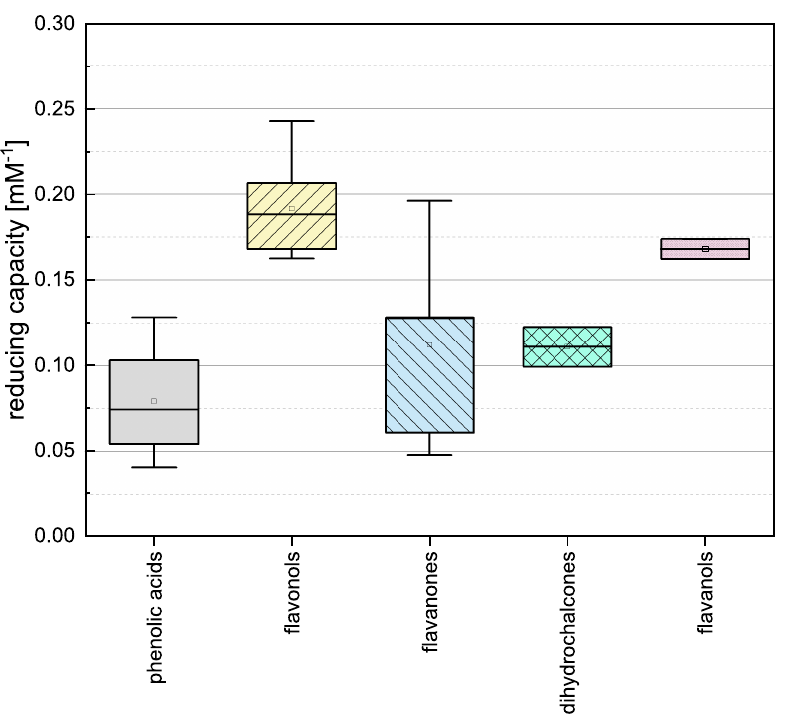
Figure 3. Boxplot of the mean reducing capacities of different subgroups of phenolic compounds (phenolic acids, flavonoles, flavanones, dihydrochalcones, flavanoles) in the FC assay. Error bars represent range within standard errors (1.5 interquartile range).